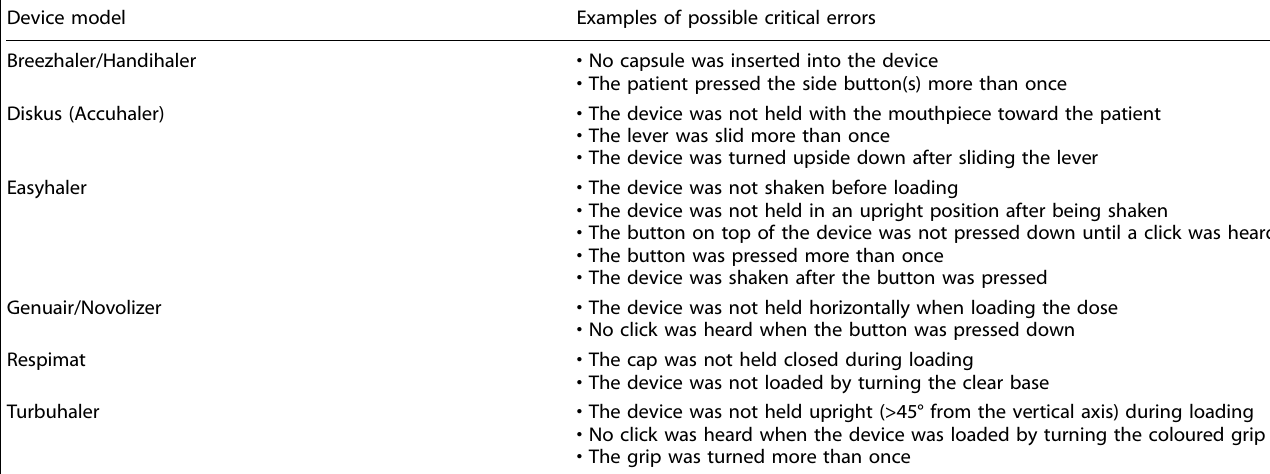
Table 4. Examples of possible critical errors performed during dose preparation and loading for device models included in the study. Device model Examples of possible critical